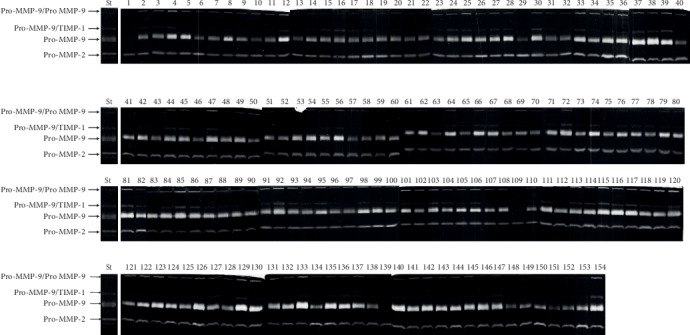
Gelatin zymography of the 154 analysed serum samples. Each lane represents a different subject. Experiments were performed in triplicate, and the densitometric bands were quantified by using ImageJ software. St represents protein samples extracted from human breast cancer tissues used as standard.